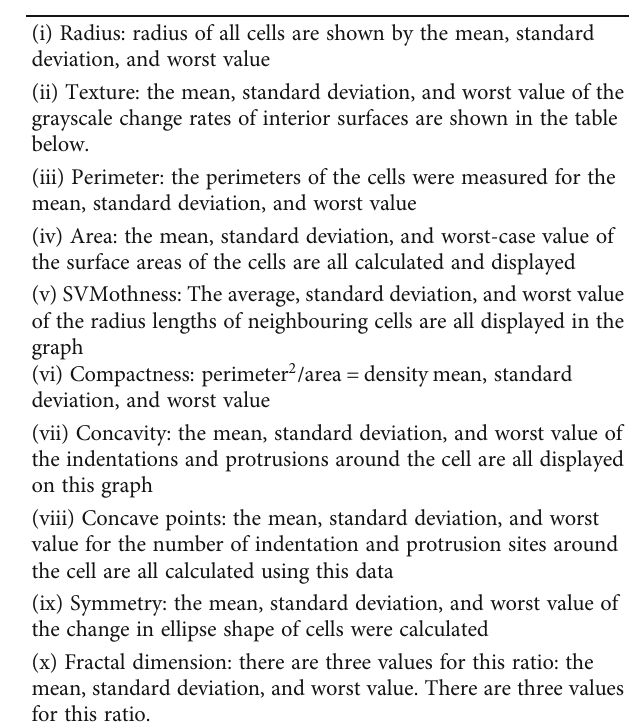
Table 1: Characteristics of the samples.